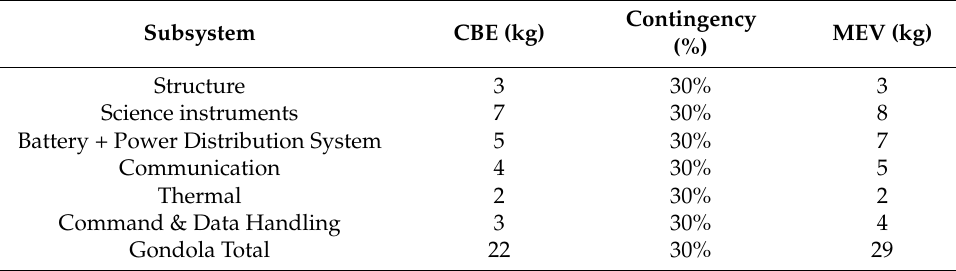
Table 7. Mass breakdown of the balloon